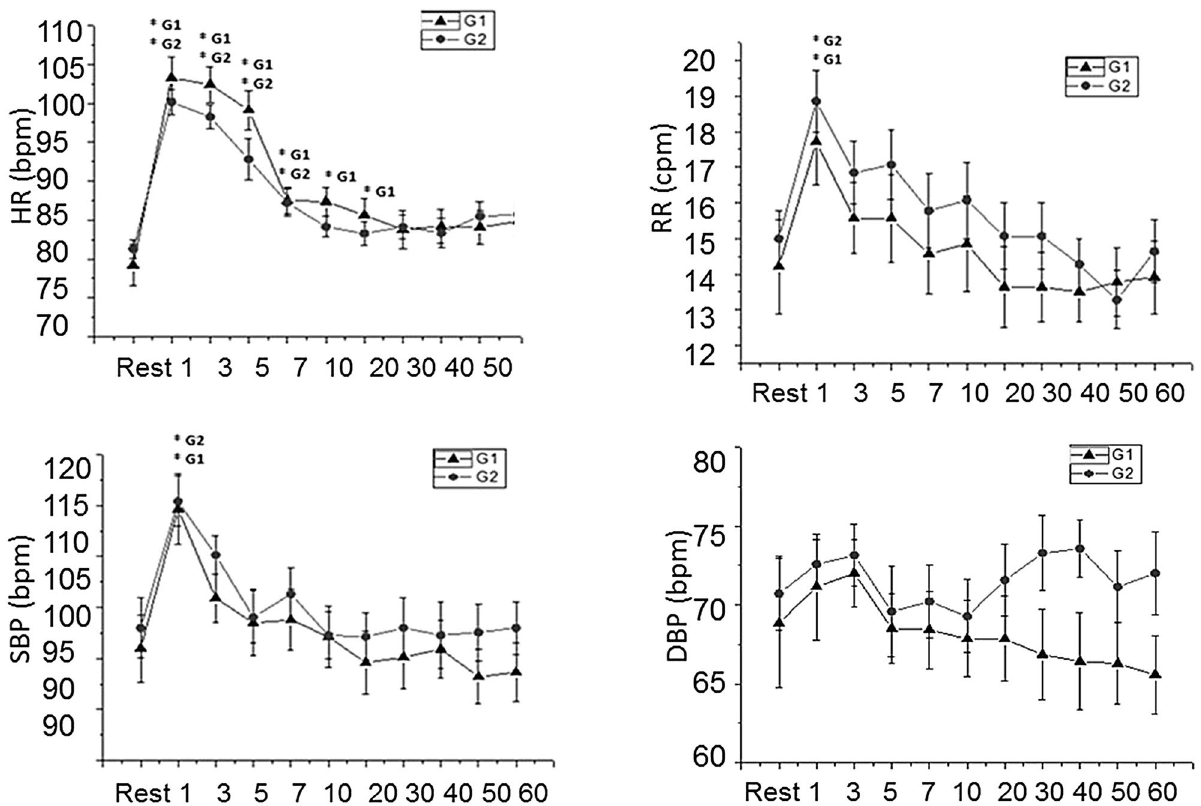
Figure 3. Mean values and respective standard deviations of HR, RR, SBP and DBP obtained at rest and during recovery from moderate aerobic exercise protocol. *G1 and *G2: values with significant differences in relation to rest (p < 0.05) for G1 and G2, respectively. SBP systolic blood pressure, DBP diastolic blood pressure, HR heart rate, RR respiratory rate, mmHg millimeters of mercury, bpm beats per minute, cpm cycles per minute, G1 birth weight between 2400 and 3200 g, G2 birth weight between 3200 and 4500